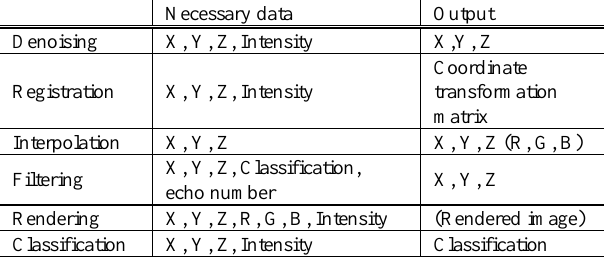
Table 1. Necessary data for point cloud